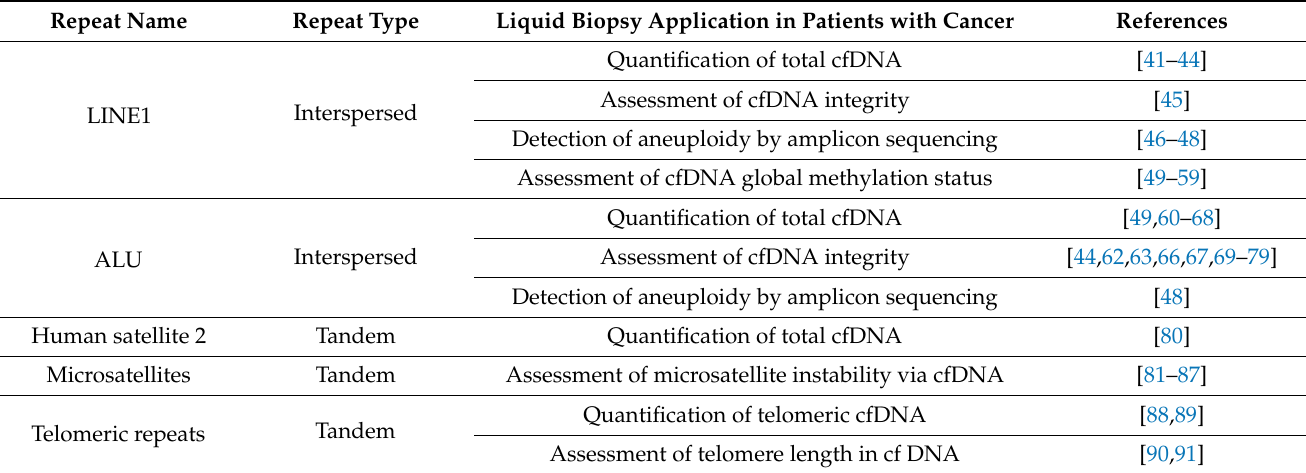
Table 1. An overview on applications of repetitive DNA elements in liquid